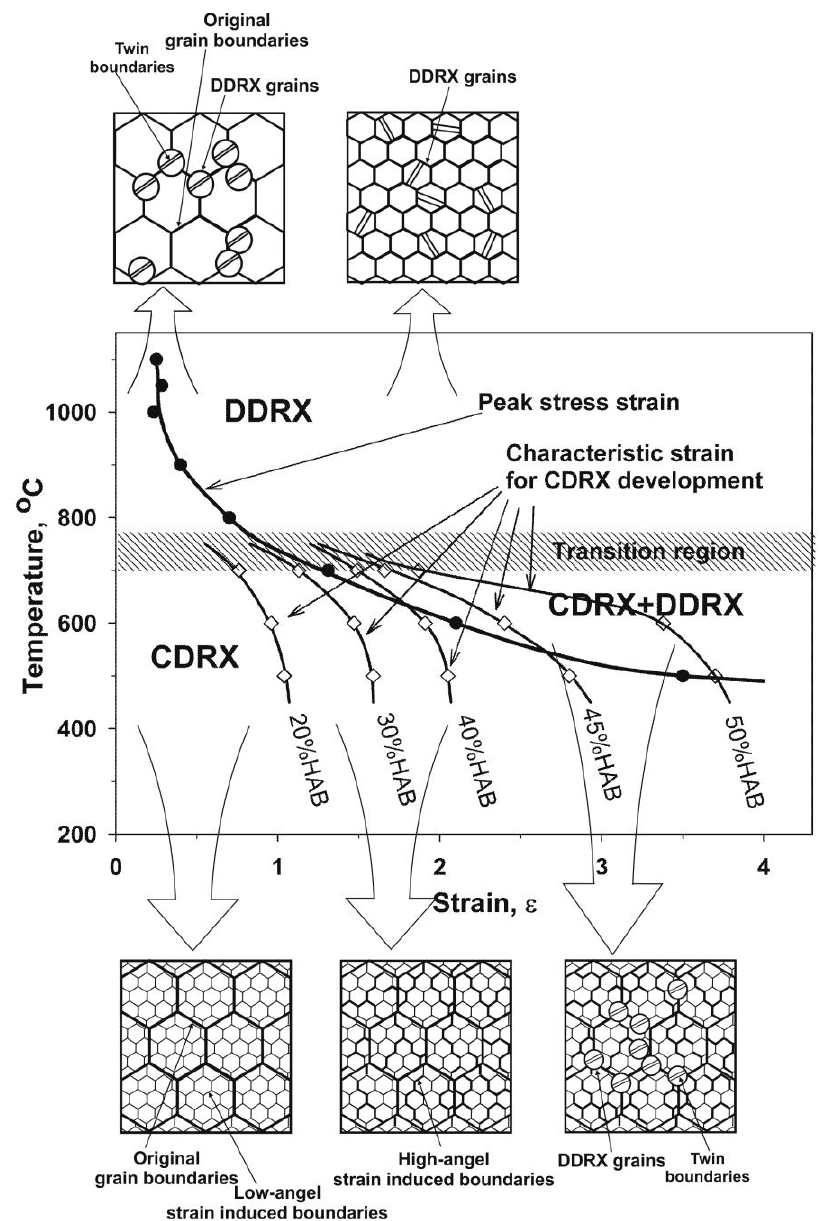
Figure 13. Schematic representation of the development of discontinuous DRX (DDRX) and continuous DRX (CDRX) in a 304-type stainless steel during warm-to-hot working. Reproduced from [65] with permission from Elsevier, 2023.